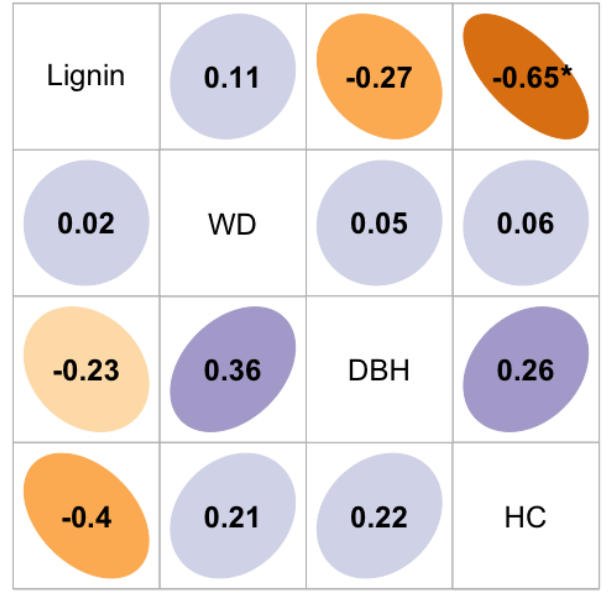
Figure 1. Estimates of genetic correlation (up Triangle) and phenotypic correlation (bottom Triangle).